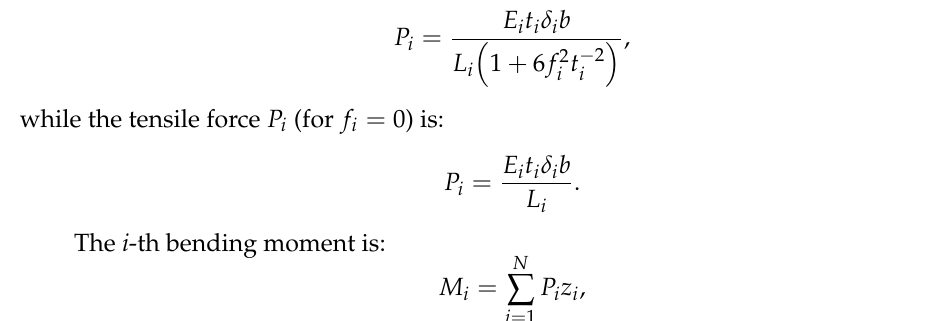
Figure 8. Corrugated board bending–compressing the layer of higher fluting.